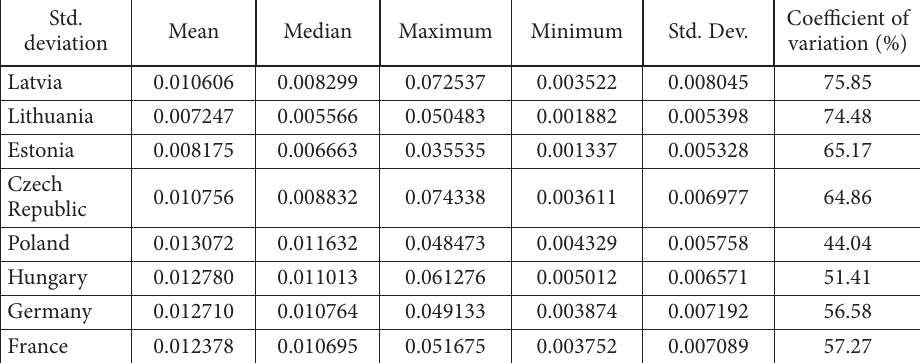
Table 1. Descriptive statistical indicators for the stock markets’ volatility Std.